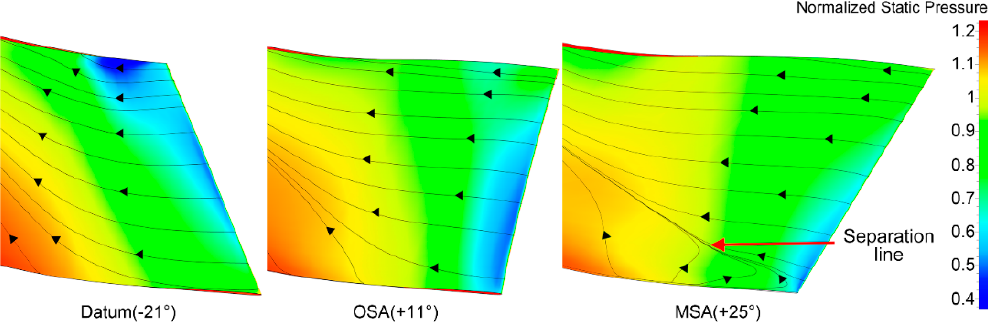
Figure 19. Contours of static pressure and streamlines on the suction surface of main blade.